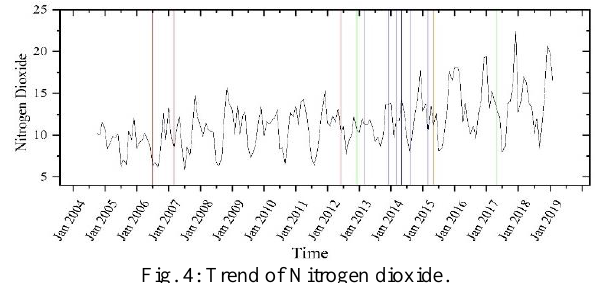
Fig. 4: Trend of Nitrogen dioxide.